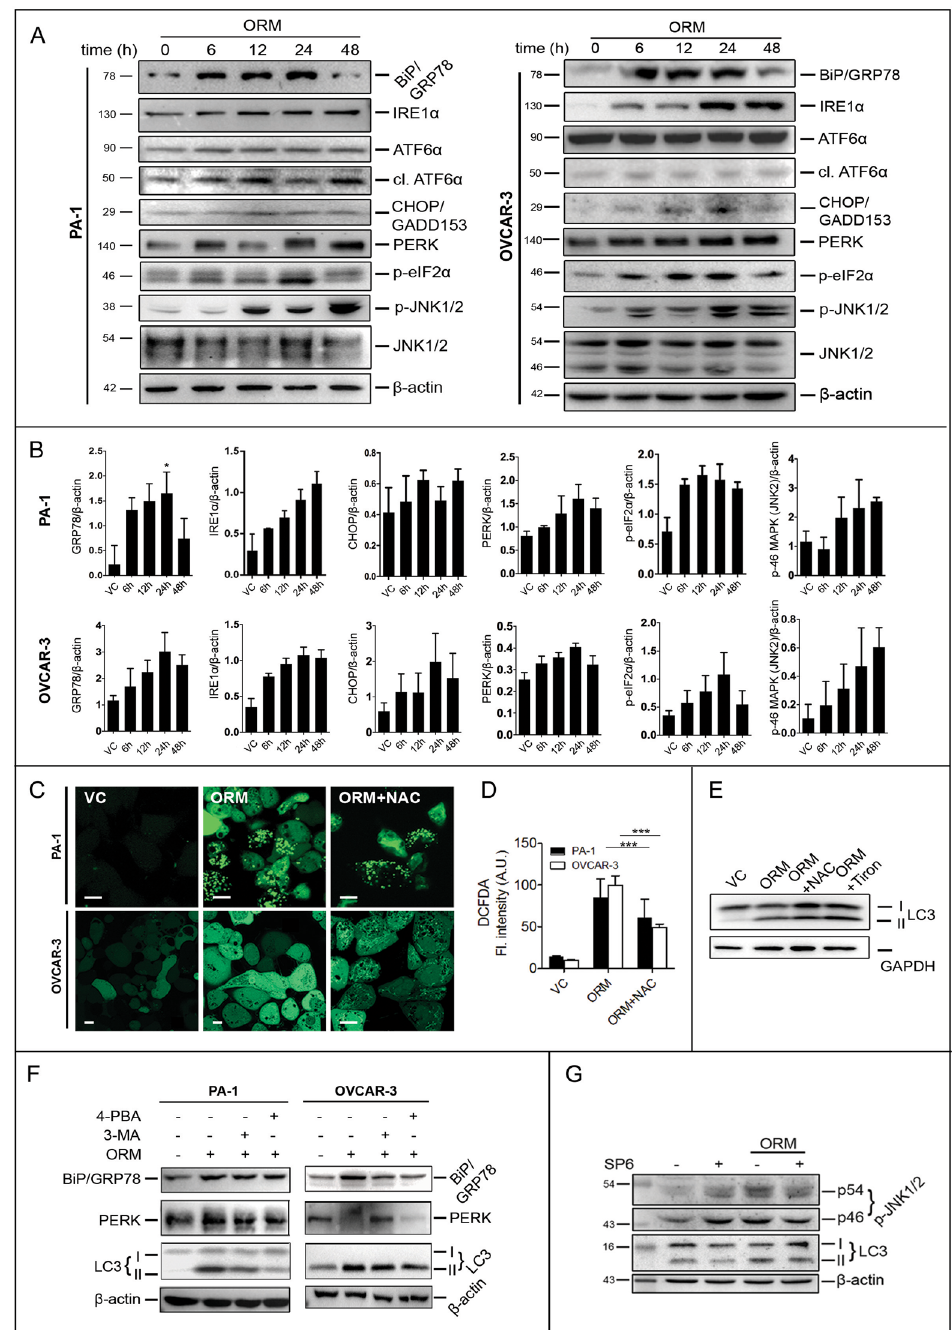
Figure 5. Upregulation of UPR proteins activate ER stress response, generation of reactive oxygen species and JNK activation, which in turn regulate autophagy. ( A ) PA-1 and OVCAR-3 cells were treated with ORM IC 50 dose for indicated time-points and immunoblotted for UPR sensor proteins PERK, ATF6 and IRE1 as well as ER chaperone GRP78/BiP, downstream transcription factor CHOP/GADD153 and eukaryotic translation initiation factor eIF2 α , apart from phosphorylated JNK (p-JNK) levels. ( B ) densitometric analyses of data represented in ( A ). ( C ) PA-1 and OVCAR-3 cells were grown in confocal glass-bottom dishes, treated with IC 50 dose of ORM for 24 h followed by staining with CM-H 2 DCFDA, a live-cell ROS marker, and imaged in confocal microscope. ( D ) Quantification of fluorescence intensity of each cell from data such as ( B ) as described in Methods. ( E ) PA-1 cells were pre-treated with NAC (5 mM, 2 h) or Tiron (5 μ M, 1 h), treated with ORM (24 h) and LC3 conversion was analysed by western blotting. ( F ) PA-1 and OVCAR-3 cells were pre-treated or not with 4-PBA (5 mM; 2 h) or 3-MA (2.5 mM; 2 h) before treating with IC 50 dose of ORM and immunoblotting for GRP78 and PERK for quantification of ER stress and LC3 for quantification of autophagy. ( G ) PA-1 cells were pre-treated or not with small-molecule JNK inhibitor SP600126 (SP6; 10 μ M,1 h) before IC 50 ORM treatment and immunoblotted for LC3 as a marker of autophagy. ( E ) Scale bars = 10 μ